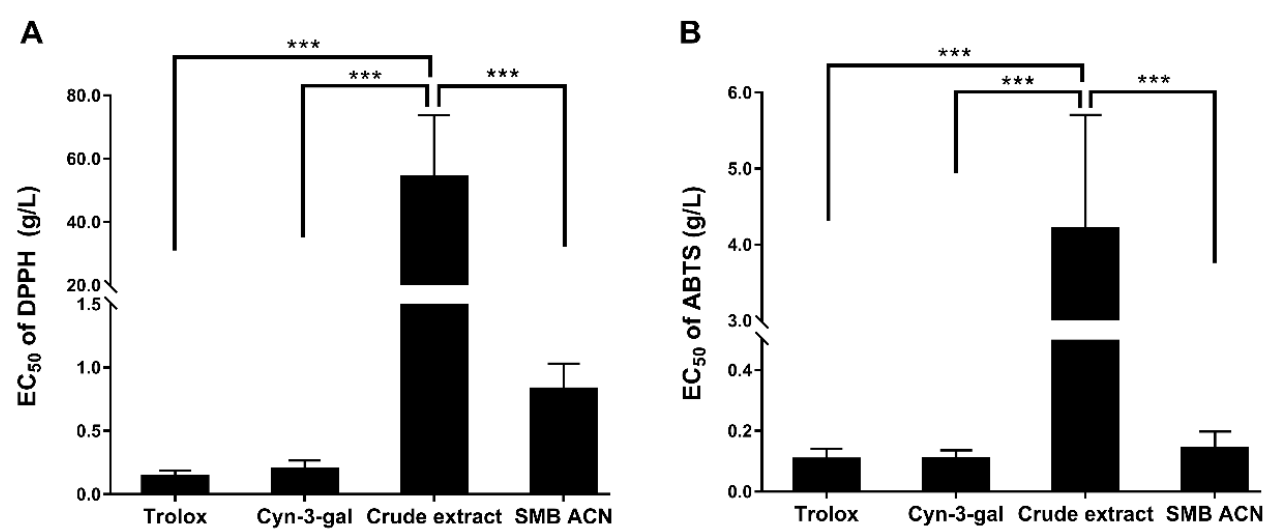
Figure 4. ( A ) DPPH free radical scavenging activity of Trolox, cyanidin 3- O -galactoside (Cyn-3-gal), anthocyanins crude extract and SMB ACN; ( B ) ABTS free radical scavenging activity of Trolox, Cyn-3-gal, anthocyanins crude extract and SMB ACN. Date represent mean ± SD ( n = 6) were expressed by the EC 50 inhibition of the free radical scavenging and the *** p < 0.001 by LSD test of one-way ANOVA.